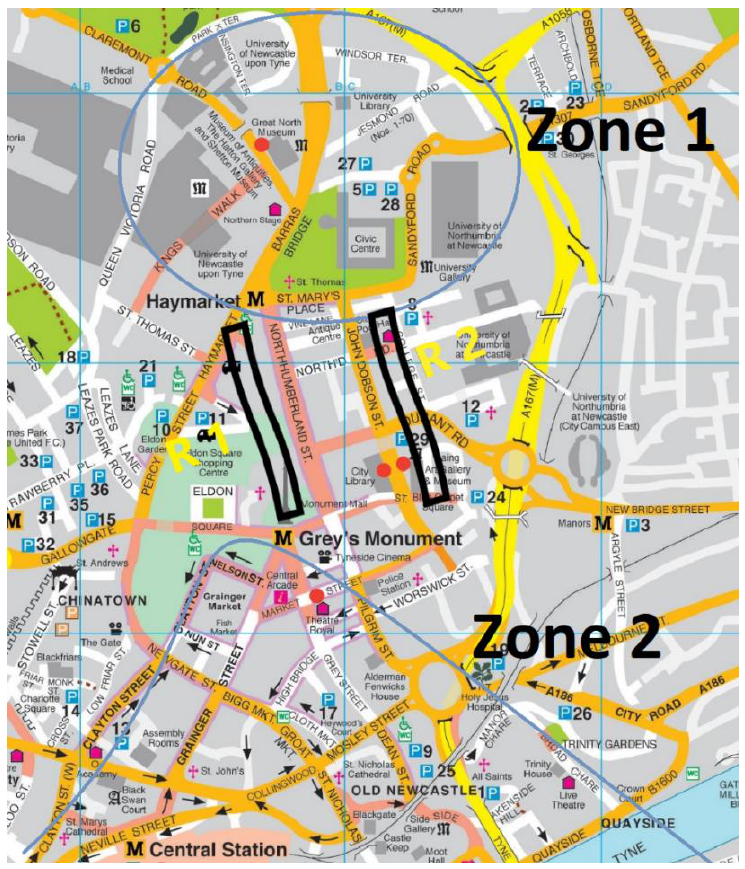
Figure 4. Application of route choice toolkit in the city centre of Newcastle upon Tyne.